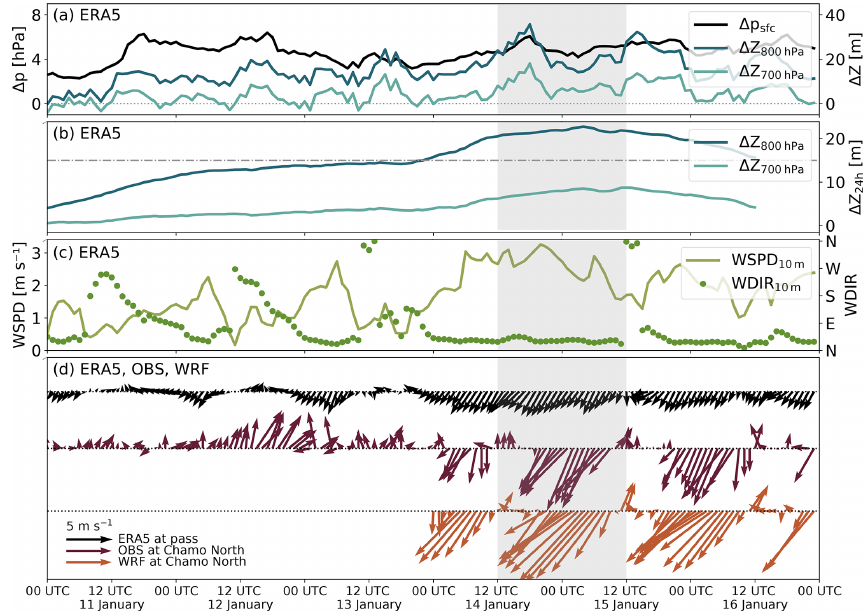
Figure 3. Time series from 11 to 16 January 2020 of (a) difference between two ERA5 grid points (Fig. 1b), one in the Afar Triangle (AT) and one in the Turkana Channel (TC), of surface pressure (cid:49)p sfc reduced to 725ma.m.s.l. as well as of geopotential height (cid:49)Z at 800 and 700hPa. (b) The 24h running mean of (cid:49)Z at 800 and 700hPa. The dash-dotted line represents (cid:49)Z = 15m. (c) ERA5 10m wind speed (WSPD) and wind direction (WDIR) for a grid point close to the pass (PA; also Fig. 1b, c). (c) Wind arrows for the same ERA5 grid point as in (b) , as well as observations and simulated WRF winds for Chamo North (CN; also Fig. 1b, c) further downstream. The period of the investigated gap flow event on 14–15 January 2020 is shaded in